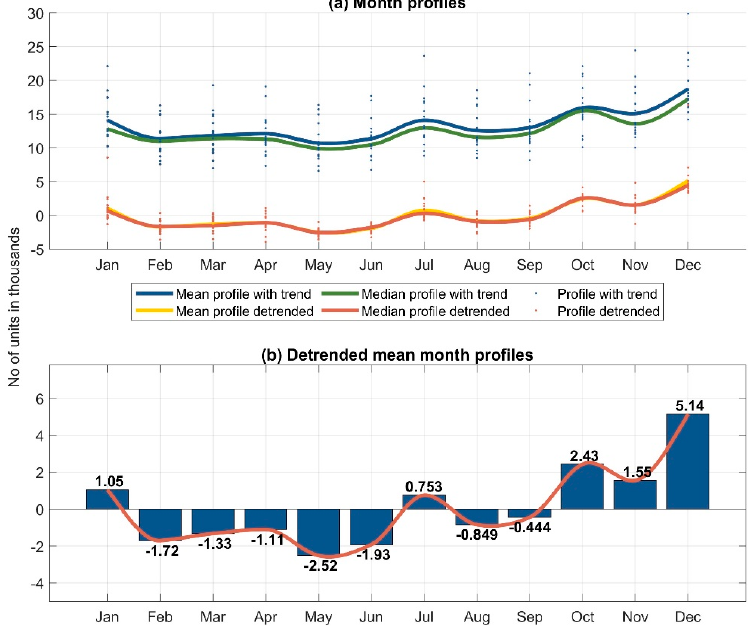
Figure 7. Averaged annual profile. Housing units put into use–total (Source: own compilation based on data from CSO).